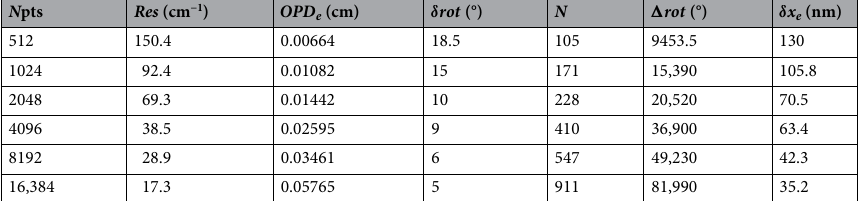
Table 1. Measurement parameters for several spectral resolution settings. Npts number of data points, Res spectral resolution, OPD e equivalent OPD , δ rot rotation increment of the HWP, N number of counted fringes, (cid:31) rot accumulated rotation, δ x e equivalent displacement